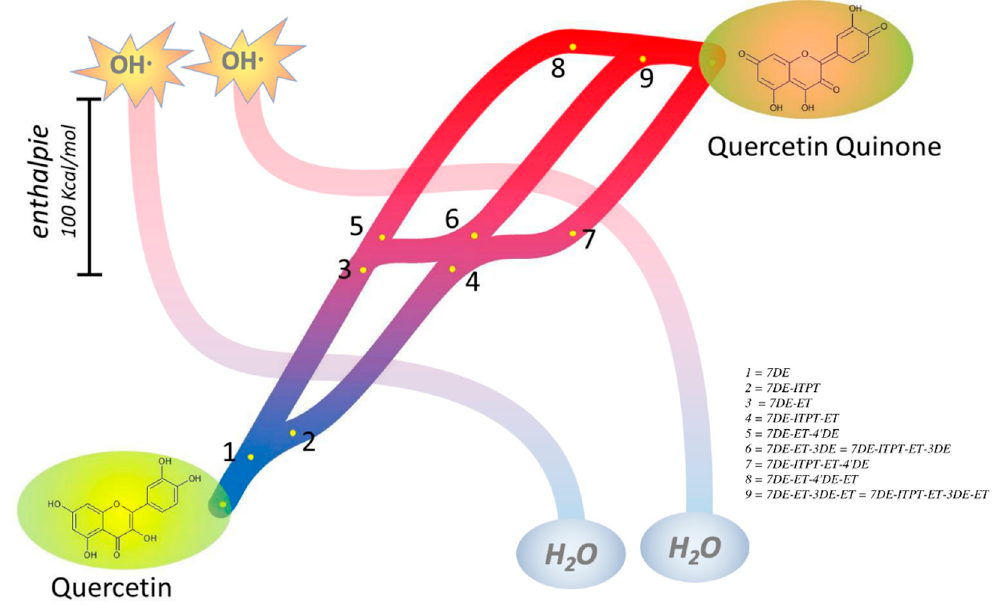
Figure 8. Overview of the main pathways of the flow of the redox energy in Q during its antioxidant activity in water. First, Q is deprotonated at the 7 position to give 7DE ( 1 ). Then the pathway spits, due to an intramolecular proton transfer, generating 7DE-ITPT ( 2 ). In one pathway, electron transfer coverts 7DE in the Q radical 7DE-ET ( 3 ). In 7DE-ET the second deprotonation can take place at the 4 ′ or 3 position, again splitting the pathway, generating 7DE-ET-4 ′ DE ( 5 ) and 7DE-ET-3DE ( 6 ), respectively. After the second electron transfer, the quinones 7DE-ET-4 ′ DE-ET ( 8 ) and 7DE-ET-3DE-ET ( 9 ) are formed. The other pathway starts with the generation of 7DE-ITPT ( 2 ). Electron transfer converts 7DE-ITPT in the Q radical 7DE-ITPT-ET ( 4 ). The second deprotonation of this Q radical ( 4 ) also can take place at two positions. Interestingly, deprotonation of the Q radical ( 4 ) at the 4 position generates a molecule identical to 7DE-ET-3DE ( 6 ), and here the pathways come together. The second deprotonation of the Q radical ( 4 ) at the 4 ′ position generates a third pathway by the formation of 7DE-ITPT-ET-4 ′ DE ( 9 ). After a second electron transfer 7DE-ITPT-ET-4 ′ DE is converted in the quinone 7DE-ITPT-ET-4 ′ DE-ET (Quercetin Quinone). Of the quinones formed, 7DE-ITPT-ET-4 ′ DE-ET (Quercetin Quinone) has the lowest energy content, and ultimately this appears to be the most abundant quinone in the antioxidant activity of Q. In these pathways, Q can pick up the hard energy of e.g., two hydroxyl radicals, and the hard energy is softened before it is passed on into the antioxidant network.